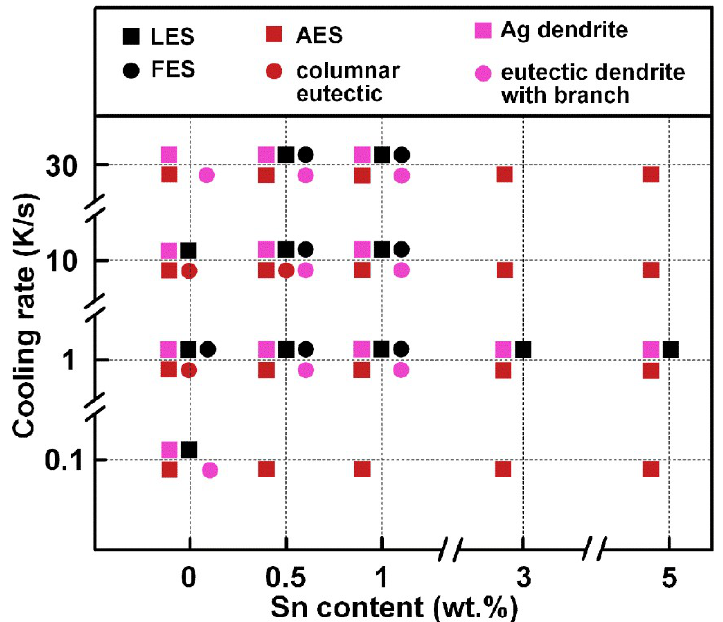
Figure 7. Solidification microstructure map for the Ag-Cu eutectic structures as a function of cooling rate and Sn content. The symbols denote LES ( ■ ), AES ( ■ ), FES (●), Ag dendrite ( ■ ), columnar eutectic (●) and eutectic dendrite with branch (●).